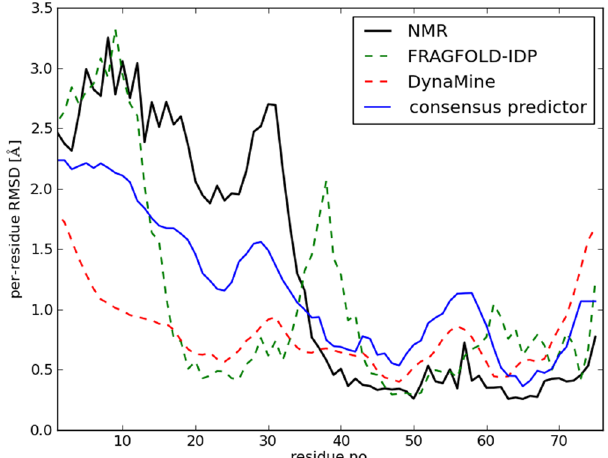
Figure 7. Example of an excellent consensus predictor result – 1P94. DynaMine (R S = 0.71) and FRAGFOLD- IDP (R S = 0.54) produce good predictions for this target. Consensus predictor performs remarkably well (R S =